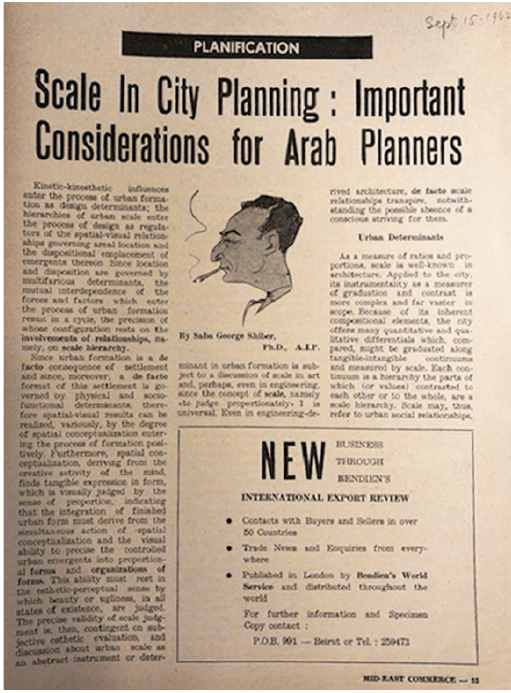
Shiber’s visual studies based on continuing the work of Hilberseimer, Gropius, and Moholy-Nagy on urbanism